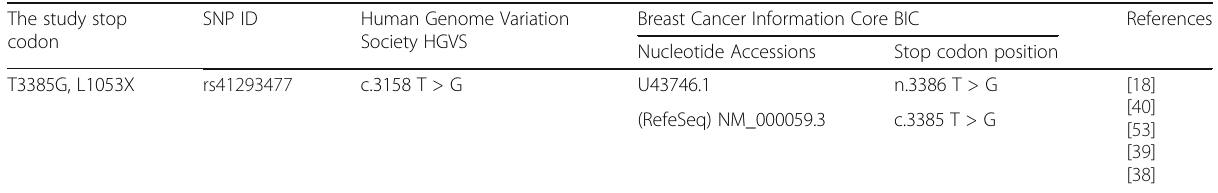
Table 5 highlights the stop codon L1053X with different nomenclatures described by ClinVar NCBI database